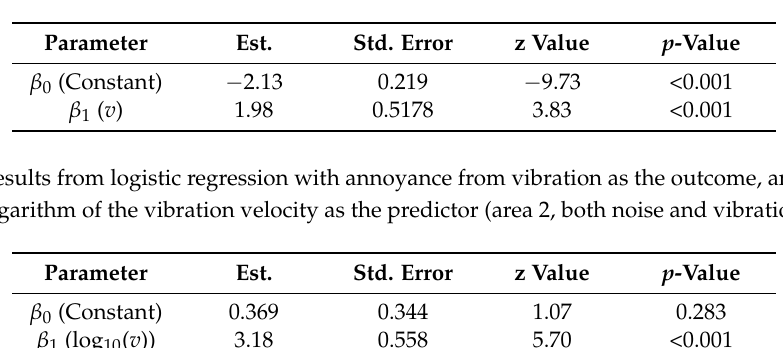
Table 5. Results from logistic regression with annoyance from vibration as the outcome (area 2, both noise and vibration).